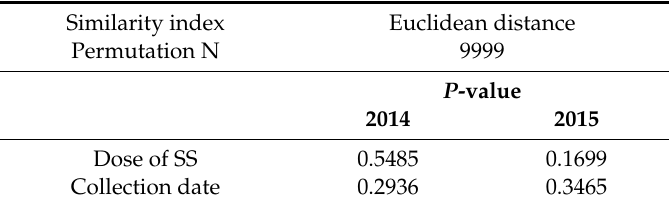
Figure 2. The principal component analysis (PCA) constructed from T-RFLP fluorescent data of fungal communities from Arundo donax rhizosphere collected in ( a ) 2014 and ( b ) 2015 in control samples and samples with sewage sludge (SS) in doses of 5 and 15 t/ha. PCA graphs explained a total of 37.56% and 50.32% (respectively) of the variability in the data. PCA was made by combining data from two sampling dates in each year into a single statistical table. Red – control sample; blue – sample with 5 t/ha of SS; green – sample with 15 t/ha of SS.